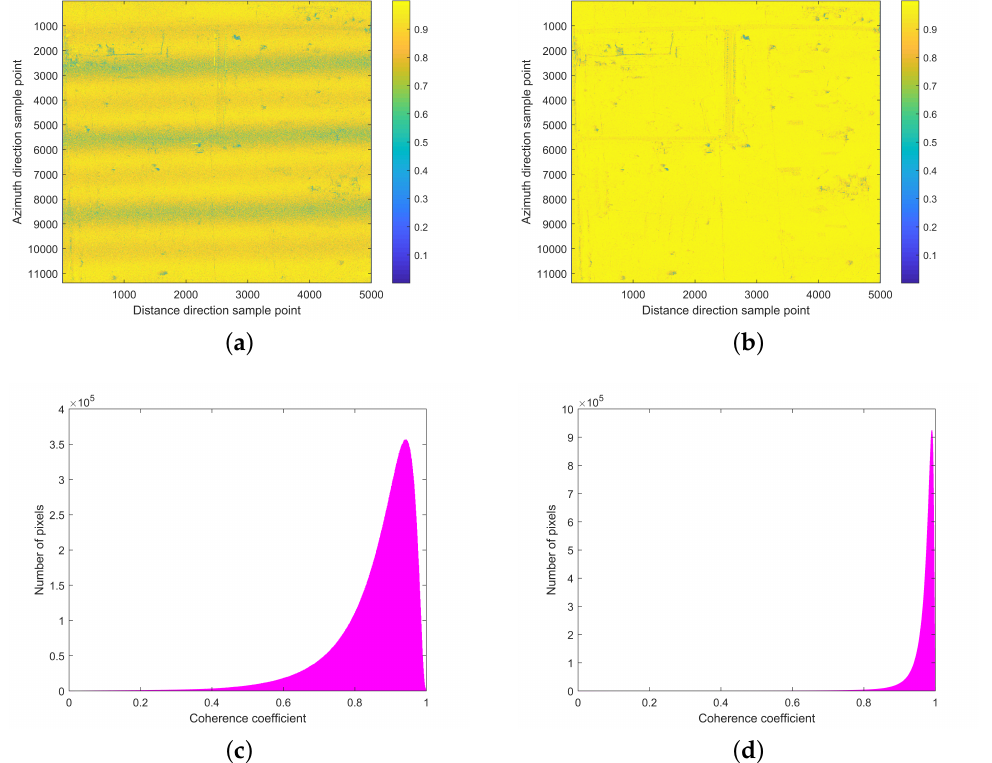
Figure 12. The comparison results. ( a ) The comparison method coherence coefficient diagram; ( b ) the proposed method coherence coefficient diagram; ( c ) the comparison method coherence coefficient statistical histogram; ( d ) the proposed method coherence coefficient statistical histogram. Next, the imaging performance of the point targets was compared. The 2D results are shown in Figure